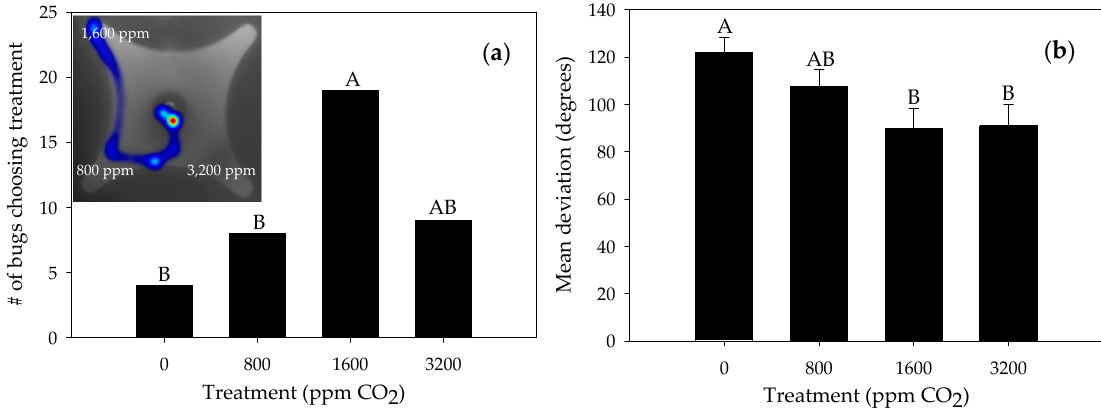
Figure 2. Responses of Triatoma rubida nymphs to different concentrations of CO 2 . ( a ) Number of bugs choosing ports with airstreams carrying different levels of CO 2 (N = 40). EthoVision ® generated “heat maps” that visualize a subject’s frequency at specific positions based on a color gradient. The insert represents an example of the trajectory of a T. rubida nymph interacting with CO 2 streams in the olfactometer. In this case, nymphs ventured to other zone before choosing the port with 1600 ppm of CO 2 ; ( b ) Mean deviation (degrees) ± Standard Error (SE) of nymphs in each zone near each port (N = 51). Within each panel, bars with the same letter are not significantly different (Ransacking analysis, Fisher’s least significant difference (LSD), p > 0.05).